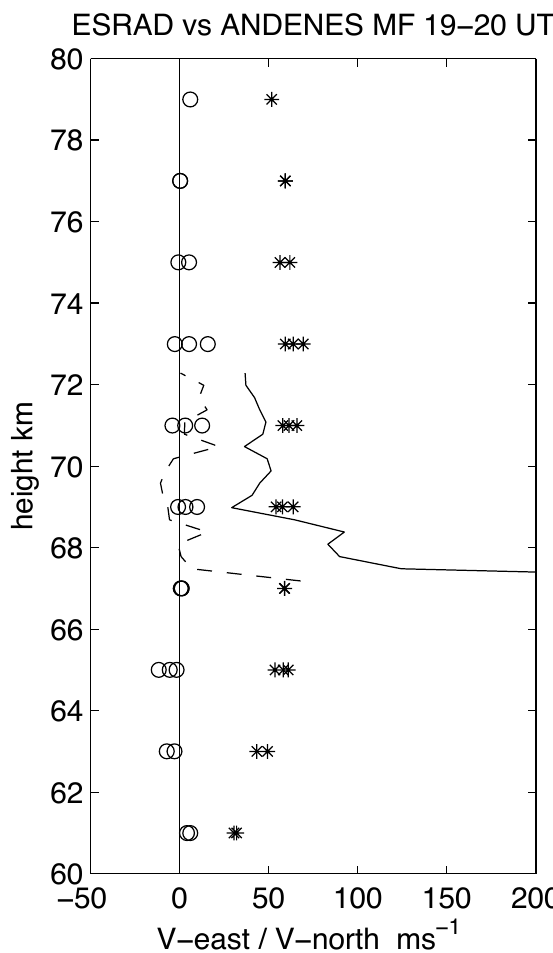
Fig. 10. Profiles of the results of ESRAD scatterer drift-speed anal- ysis averaged between 19:00–20:00UT (solid line is eastward drift, dashed line is northward drift), compared with winds from the An- denes MF radar for the same time interval (* show eastward wind, o show northward wind). Both 30-min and 60-min average profiles are plotted for the MF radar.